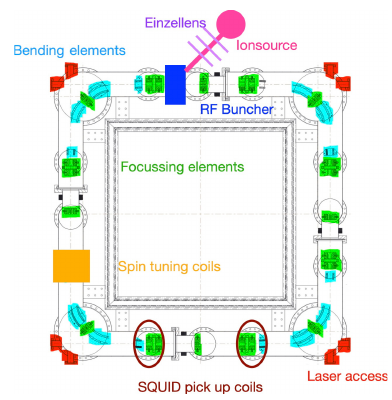
Figure 2. Beam stability simulation with sex- tupoles and double